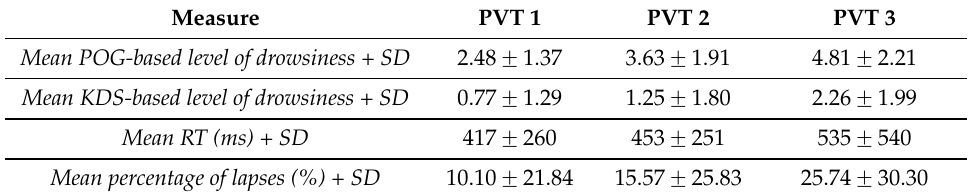
Table 1. Mean levels of drowsiness (photooculography (POG) and Karolinska Drowsiness Scale (KDS)), mean reaction time (RT), and mean percentage of lapses for all participants for the three